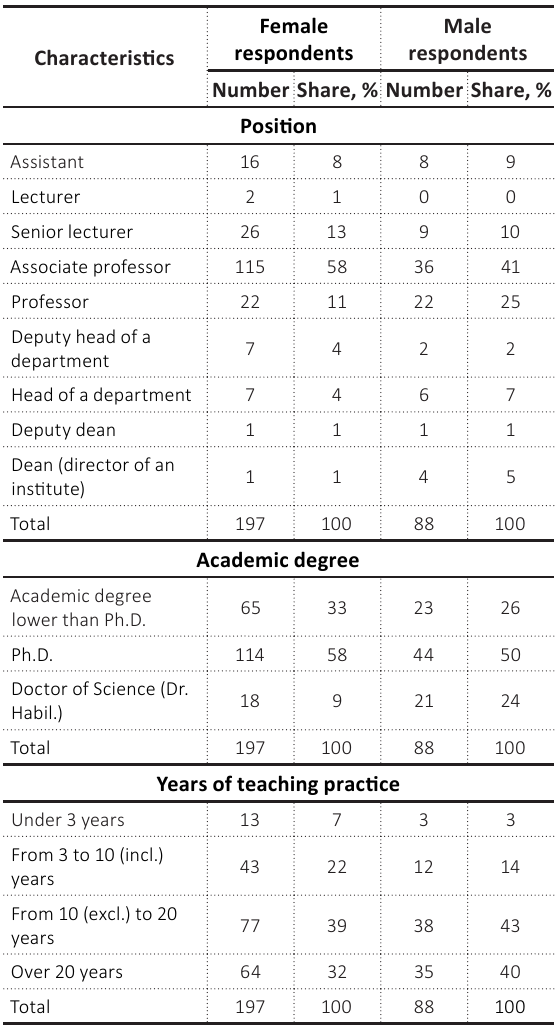
Table 2. Gender dimension of management at KNEU (unit heads and deputy heads)